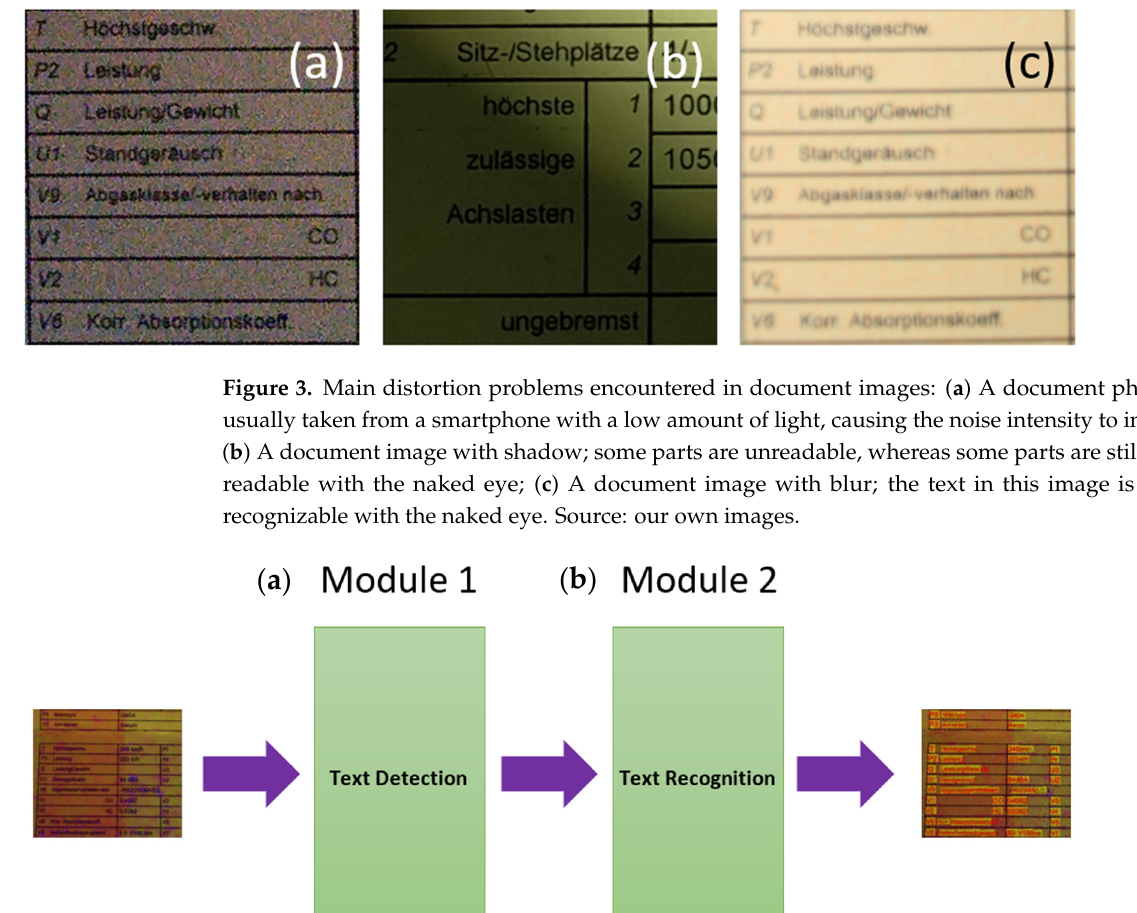
Figure 4. Our new global model, composed of ( a ) text detection (Module 1) and ( b ) text recognition (Module 2).